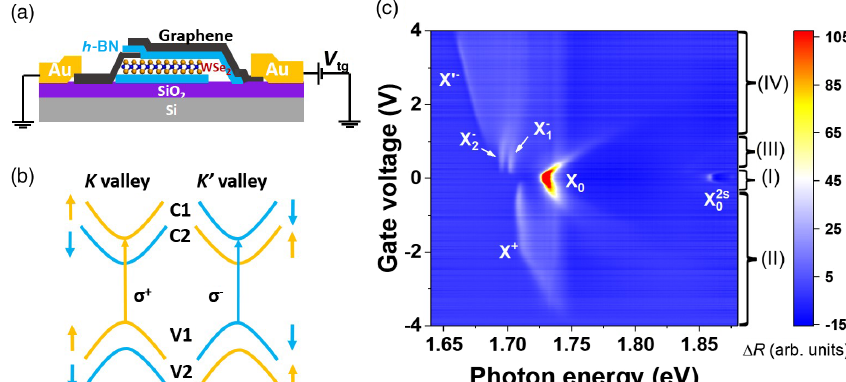
1. Optical reflectance spectra of the top-gated monolayer WSe 2 device. (a) Schematic of the BN (blue) encapsulated monolayer WSe 2 device, contacted and top gated by few-layer graphene flakes (black). (b) Schematic of the band structure of monolayer WSe 2 at K and K 0 valleys, and the exciton can be selectively excited by the right-circularly polarized ( σ þ ) or left-circularly polarized ( σ − )